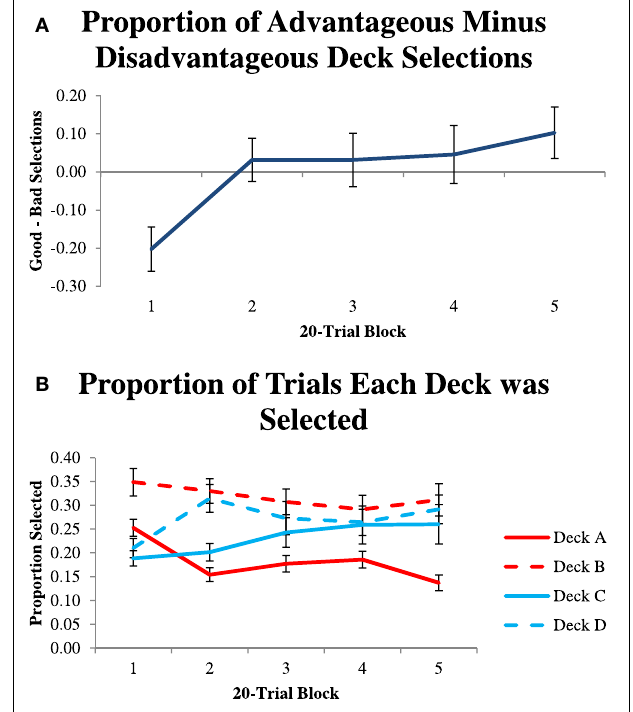
FIGURE 1 | (A) Proportion of advantageous minus disadvantageous deck selections in 20-trial blocks. (B) Proportion of trials that each deck was selected in 20-trial